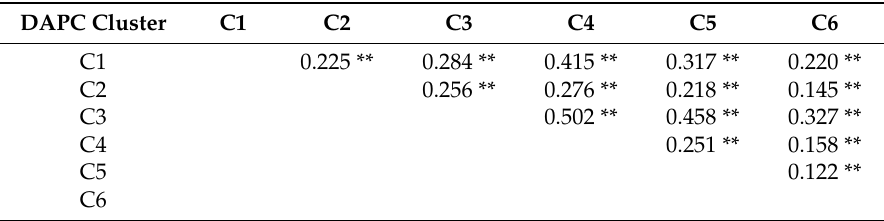
Table 3. Differentiation indices (F ST ) between all pairwise combination of clusters identified by DAPC performed on 136 durum wheat ex situ accessions and 28